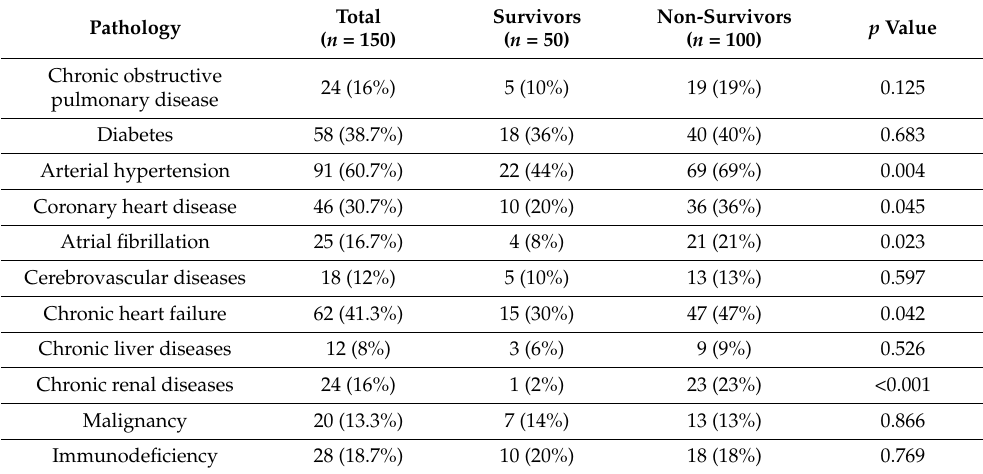
Table 2. Associated